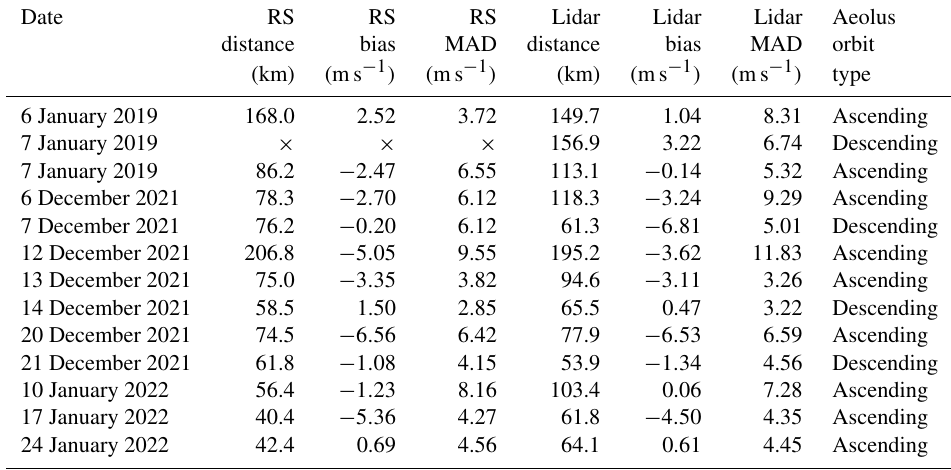
Table 2. Overview of the complete list of AboVE-OHP-1 and 2 Aeolus overpass collocations. The distance is calculated over the average position of each instrument. A more detailed table is available in the